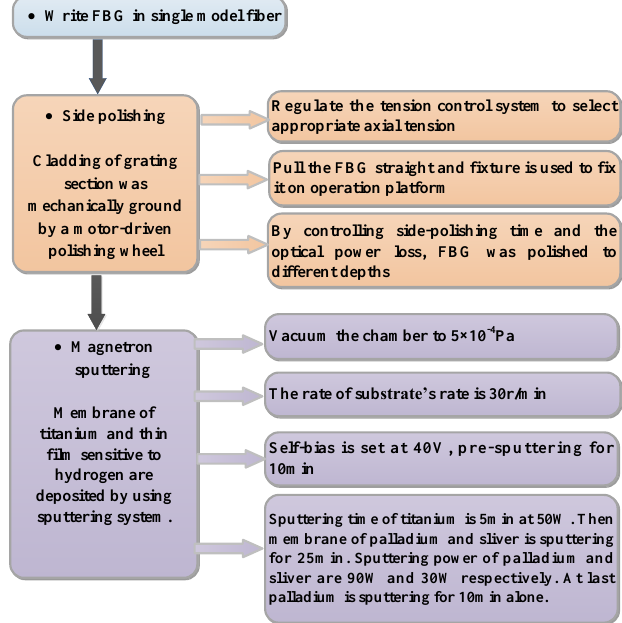
Figure 3. Flowchart of the D-shaped FBG sensor's fabrication.